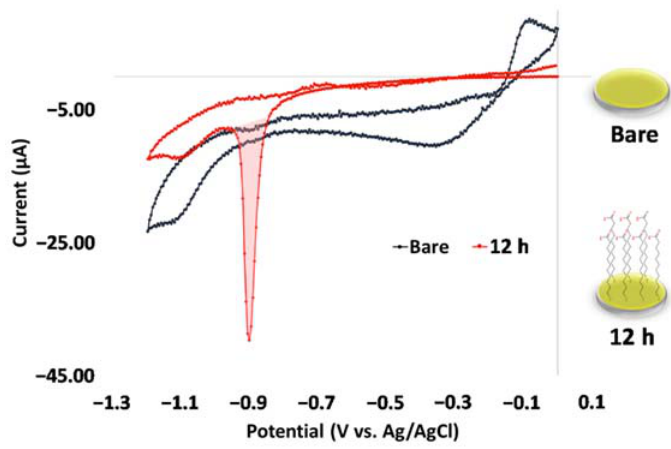
Figure 3. Characterization of the self-assembled monolayer of 11-MUA on a gold electrode by cyclic voltammetry. The cyclic voltammograms of the bare gold electrode (black) and 11-MUA-modified gold electrode (red) after 12 h of 11-MUA modification. The cyclic voltammogram of 11-MUA-modified-gold indicates the Au-S bond reduction peak area at − 0.95 V vs. Ag/AgCl (red area). Electrodes: working electrode, Au; counter electrode, Pt; reference electrode, Ag/AgCl wire (in 3.3 M KCl with a salt bridge). Scan rate: 0.1 V/s.